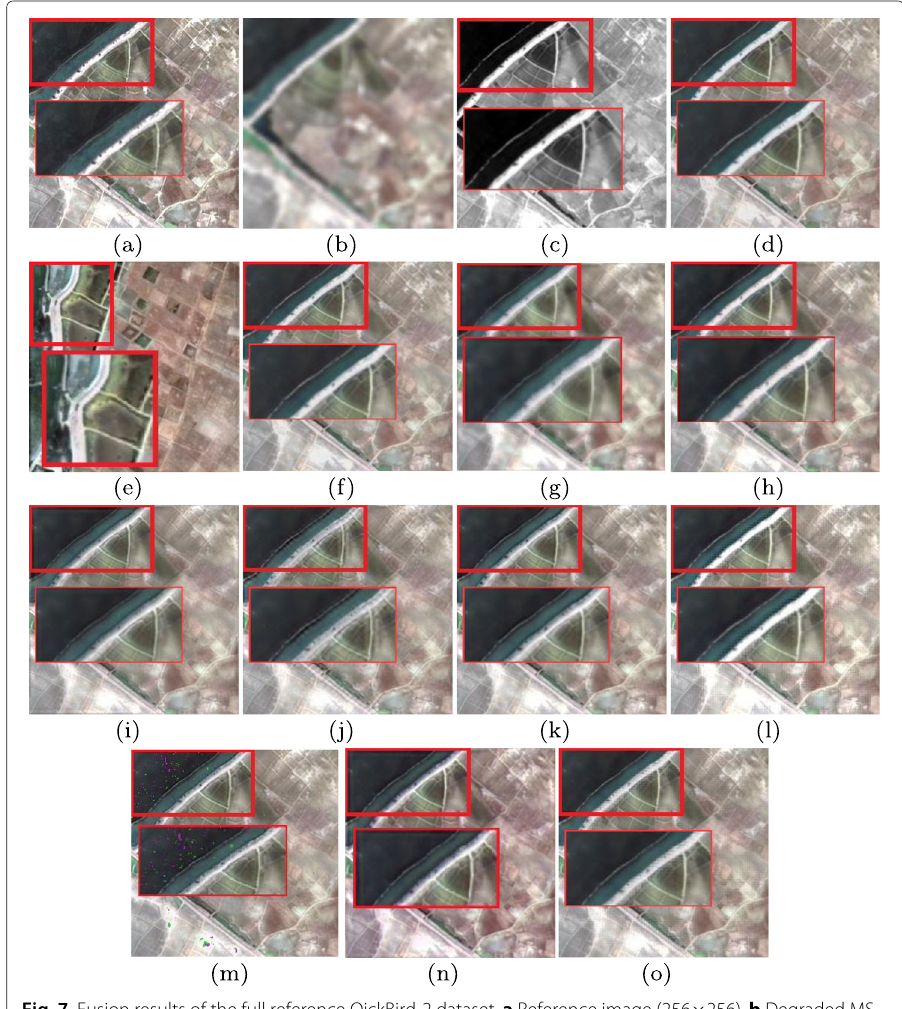
Fig. 7 Fusion results of the full reference QickBird-2 dataset. a Reference image (256 × 256). b Degraded MS image (64 × 64). c PAN image (256 × 256). d IHS method. e AIHS method. f PCA method. g BDSD method. h PRACS method. i SFIM method. j Indusion method. k MTF-GLP method. l CAE method. m MSGF method. n PNN method. o Proposed